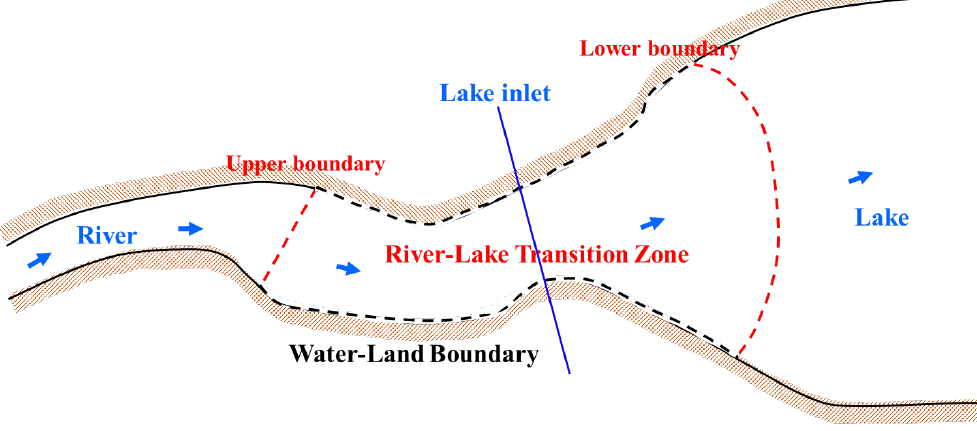
Figure 1. Locations of the upper and lower boundaries in the river – lake transition zone.